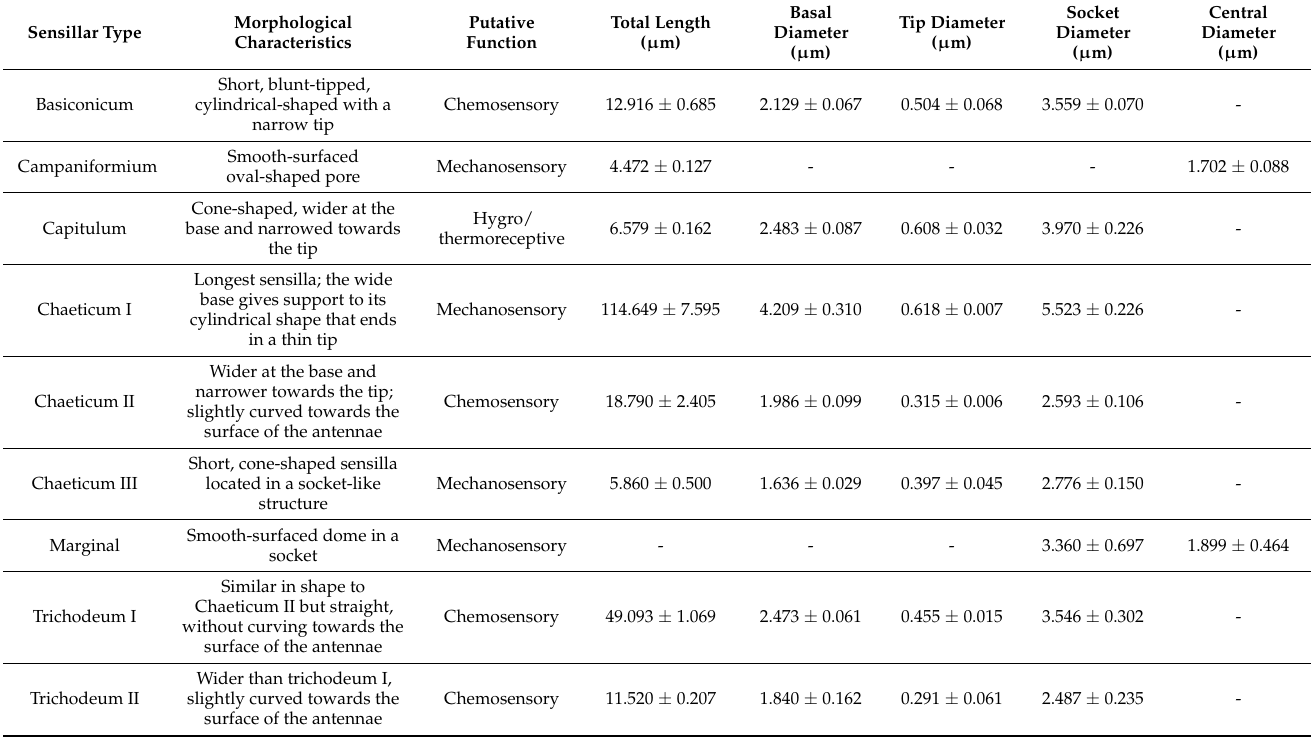
Table 2. Characteristics of sensilla. Morphological measurement data (mean ± SE, n = 3) were obtained from workers. Putative functions were determined based on morphology and location of sensilla and previously published descriptions